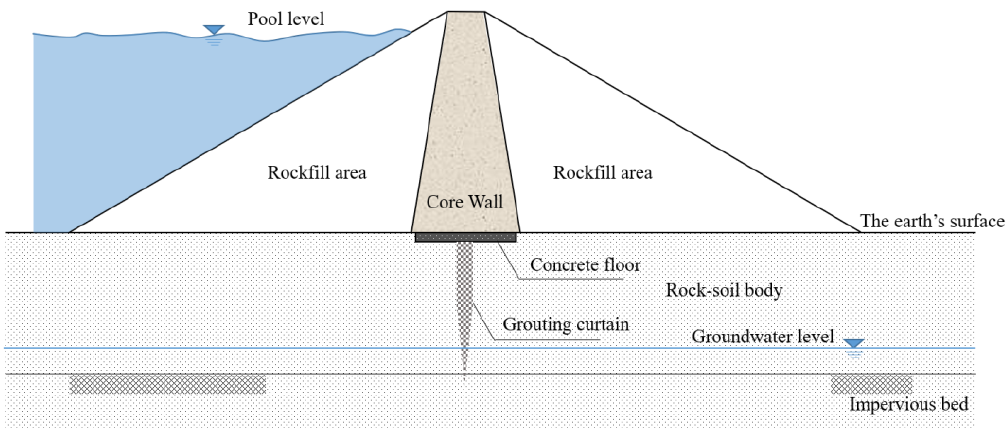
Figure 1. The simplified section view of a clay core dam.